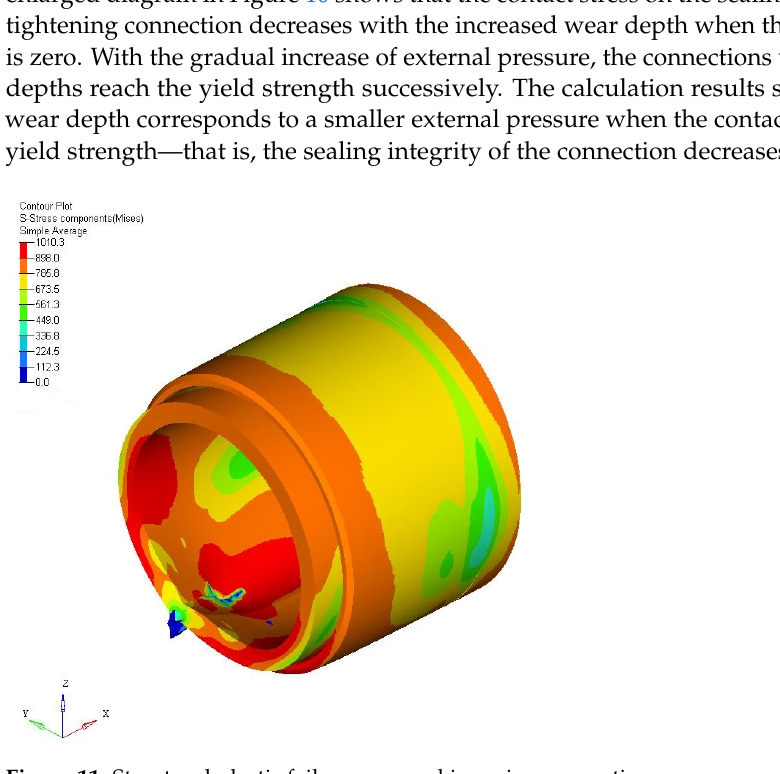
Figure 10. Change of contact stress on node A2 with external pressure and partially enlarged diagram.